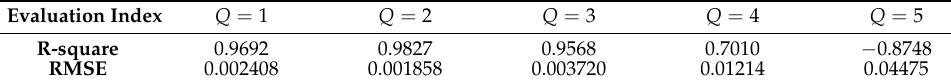
Table 3. Goodness-of-fit of nonlinear models with different cumulative terms.